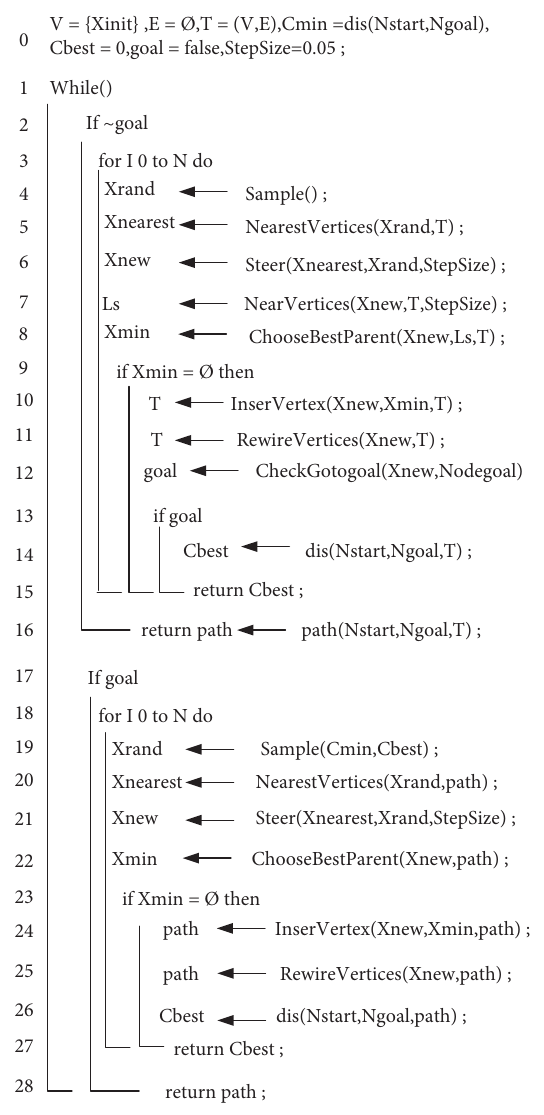
Figure 6: Improved Informed-RRT ∗ algorithm pseudocode.